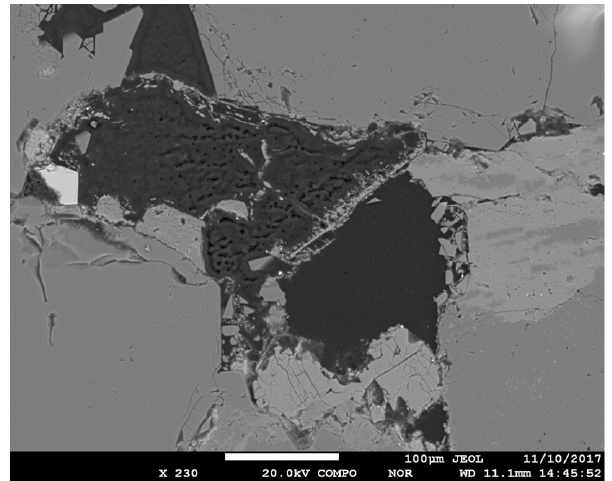
11 of 16 Figure 10. The silicon supersaturated in the pores formed autogenous and idiomorphic quartz (backscatter scanning electron microscopy). (2) Enhance stress resistance: The contact relationship between the particles has been established when the chlorite in the early pore lining began to precipitate. The increasing stiffness of the chlorite continued to grow, counterbalancing the increasing overburden during burial diagenesis (chlorite will continue to grow after precipitation; thus, chlorite